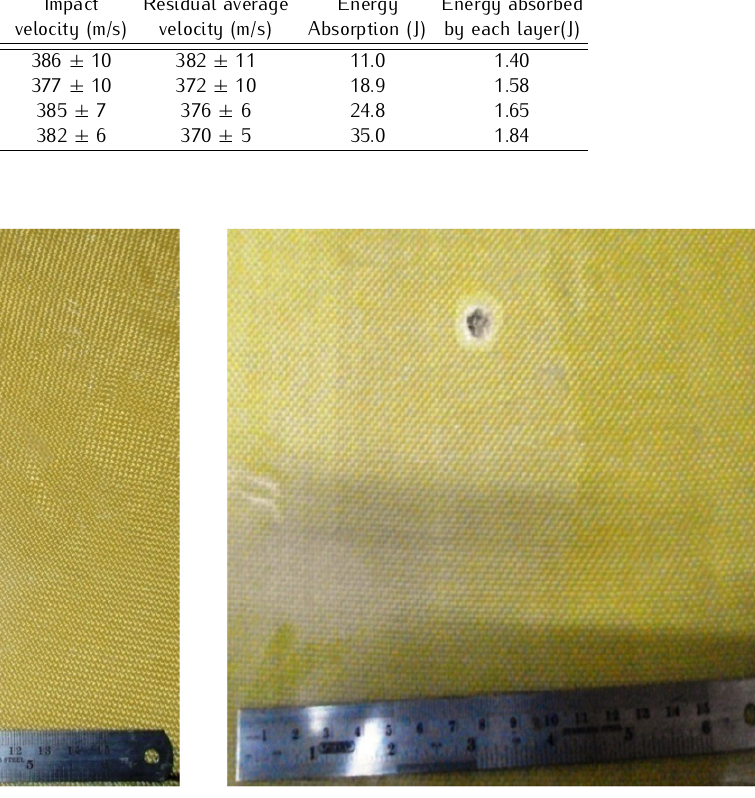
showing the least delamination area. Delamination area at